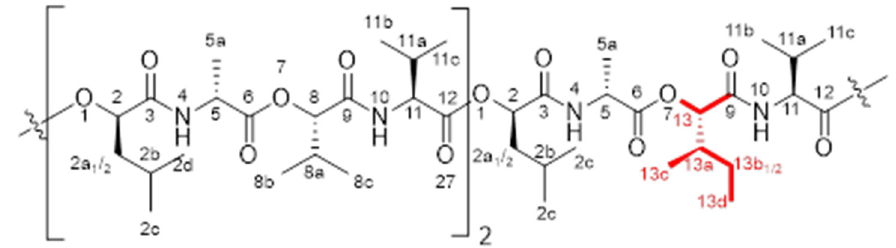
Figure 5. Open-chain chemical structure of isocereulide A (2).